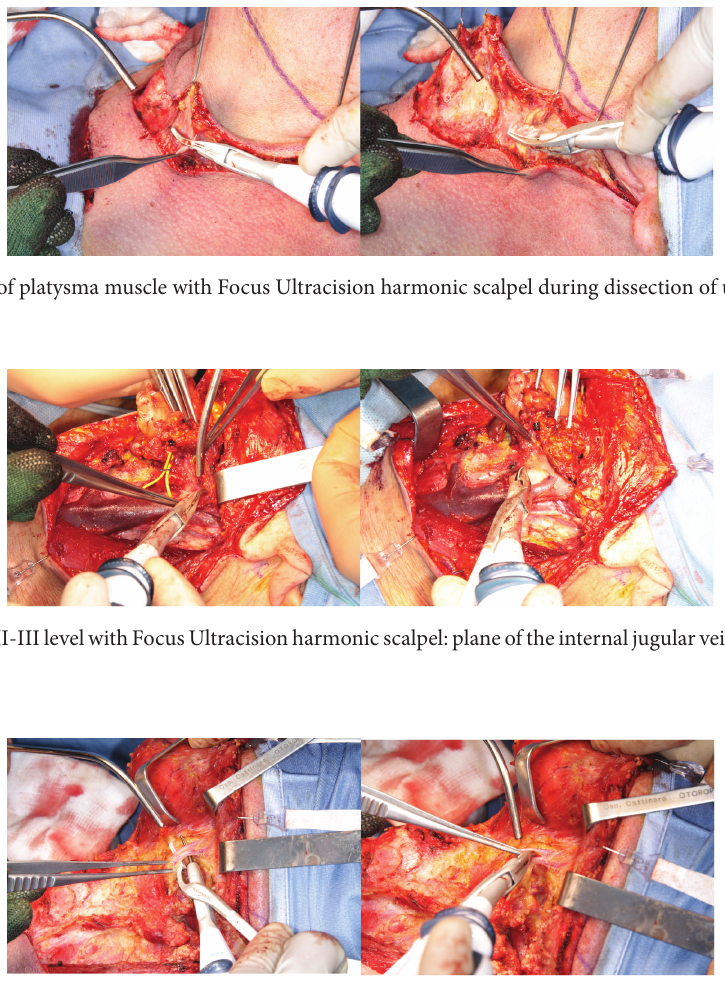
Figure 4: Neck Dissection of II-III level with Focus Ultracision harmonic scalpel: sealing of the facial